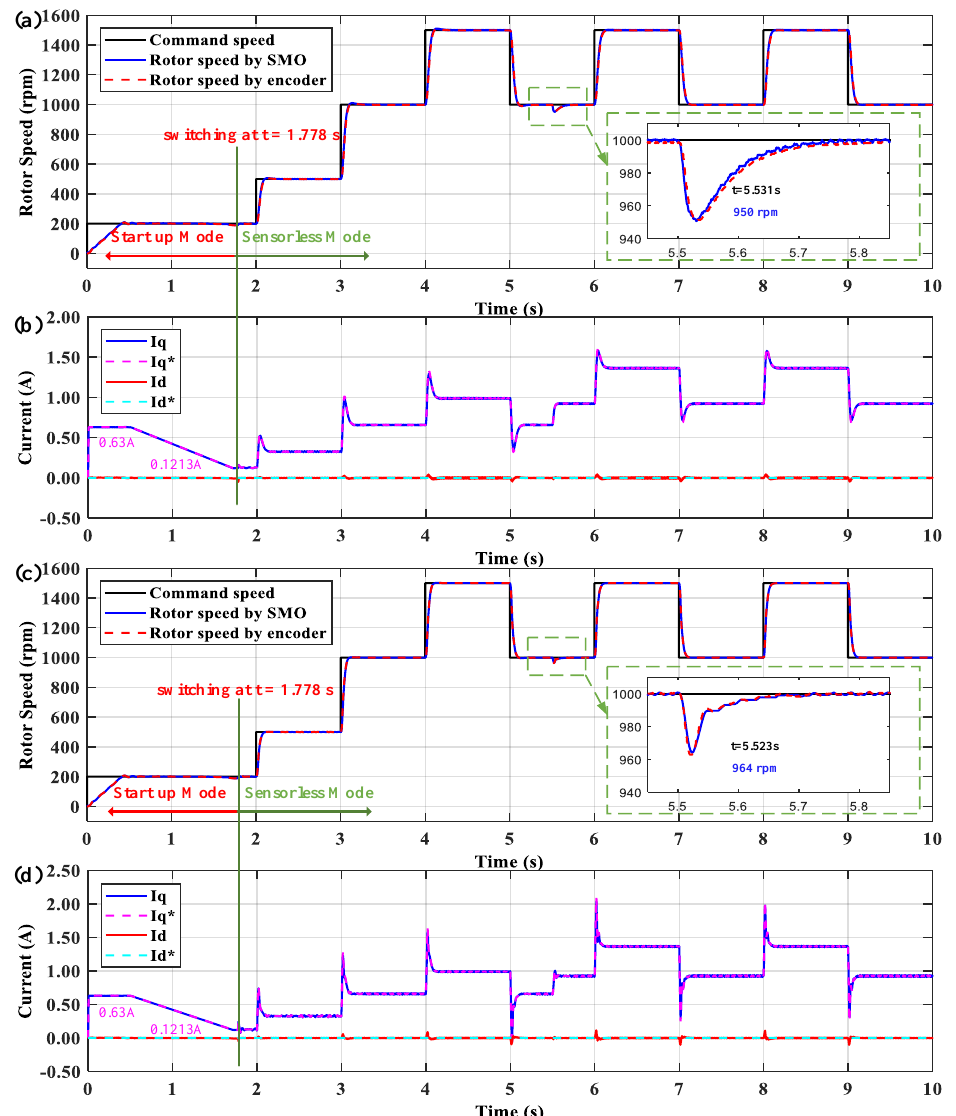
Figure 11. Simulation results for PI (Proportional-Integral) controller: ( a ) speed response; and ( b ) current response; and for NFC controller: ( c ) speed response; and ( d ) current response in the case of R L = 100 → 50 Ω.